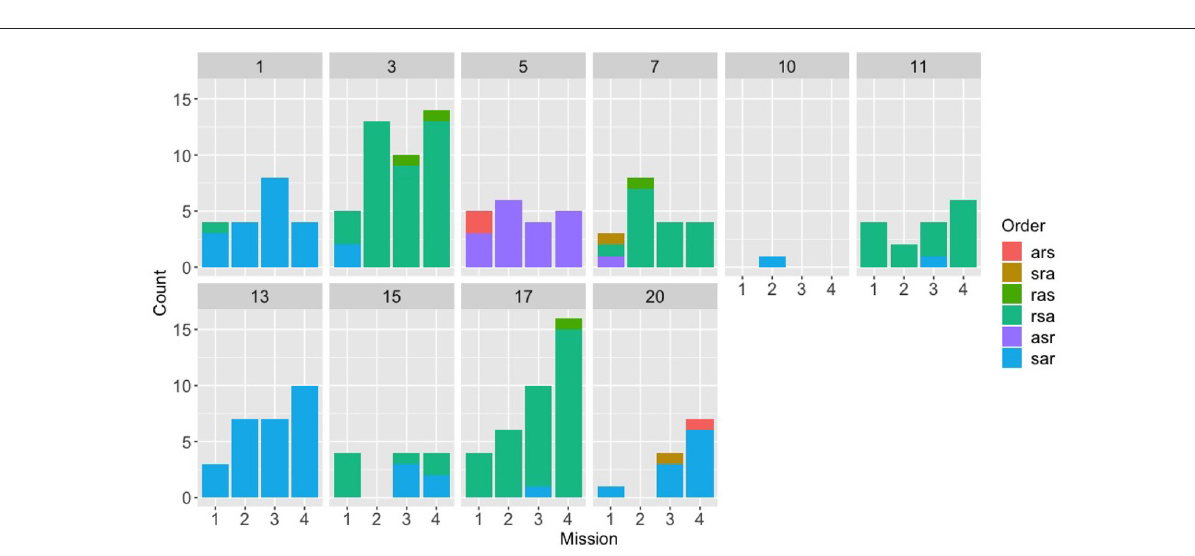
FIGURE 6 | Counts for each of the six possible orders for (s)peed, (a)ltitude, and (r)adius, across the first four missions for the text experiment, broken down by